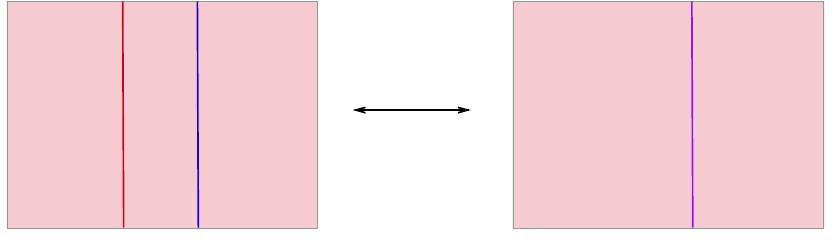
Figure 3 . Composition of